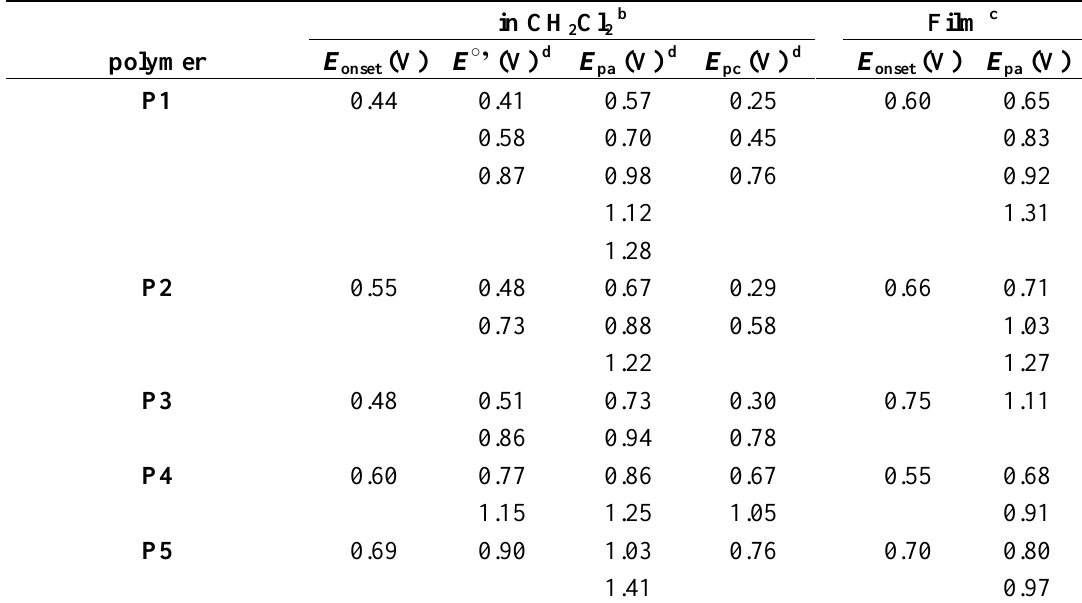
Table 2. Summary of the electrochemistry data of poly(1,8-carbazole)s a